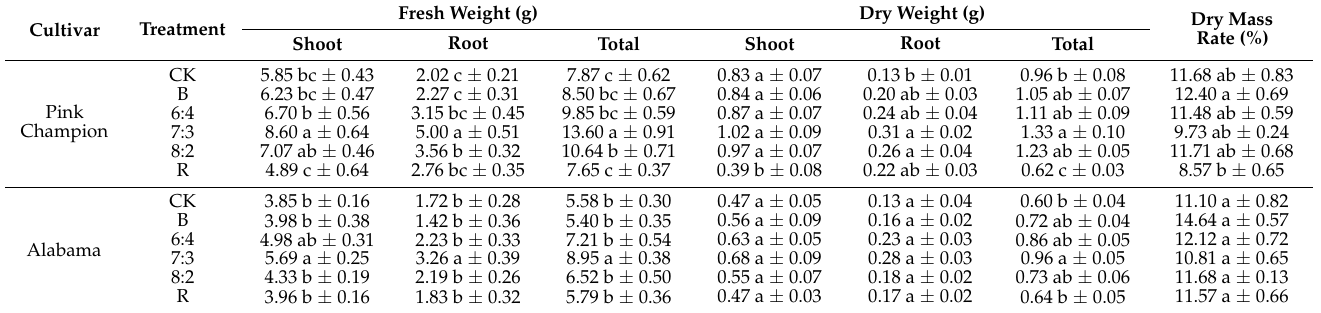
Table 2. Effects of different light qualities on fresh and dry weight of Anthurium ‘Pink Champion,